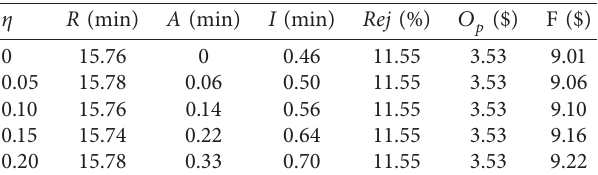
Table 5: Simulation results with different travel time standard